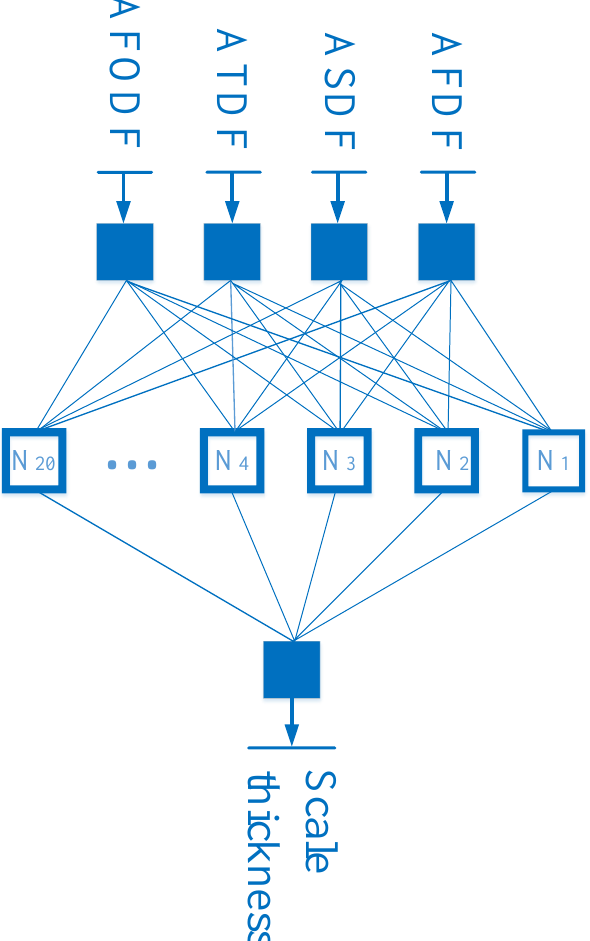
Figure 4. The trained neural network